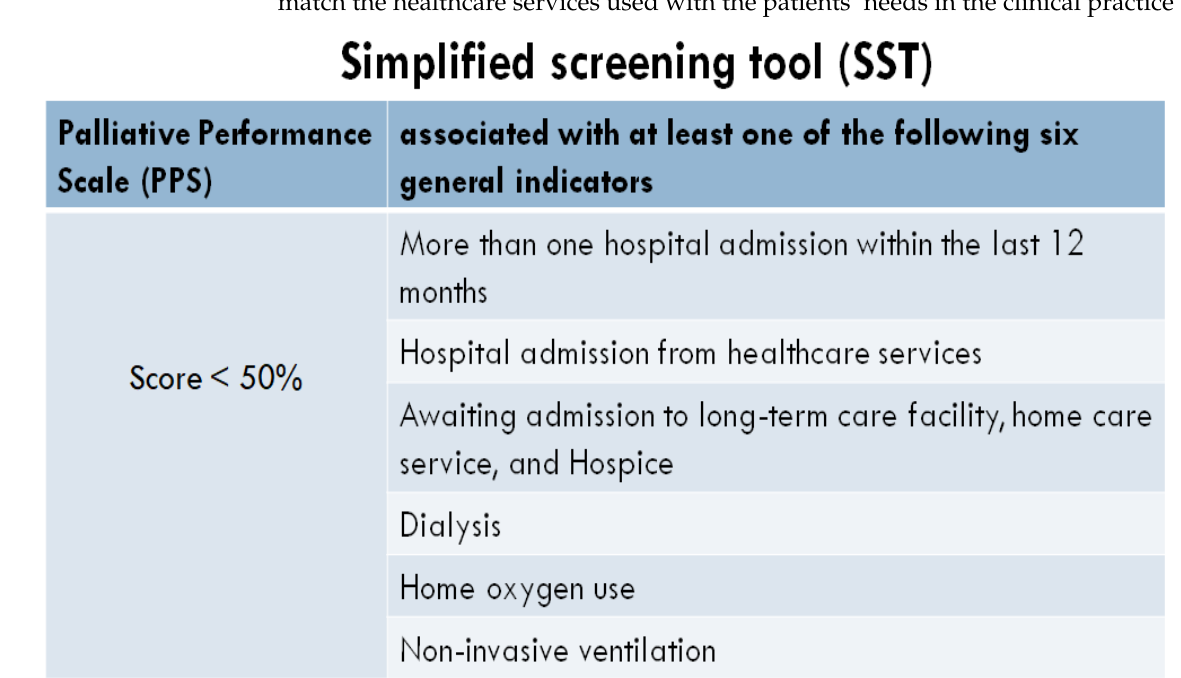
Figure 2. Simplified Screening Tool.